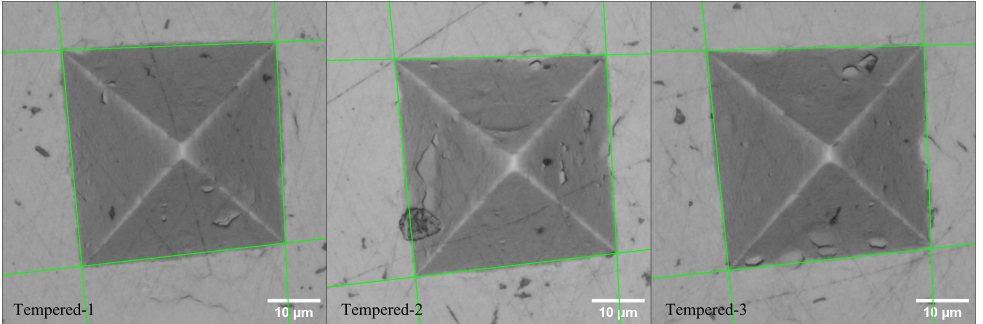
Figure A5. Corner detection on Tempering samples at 10N applied